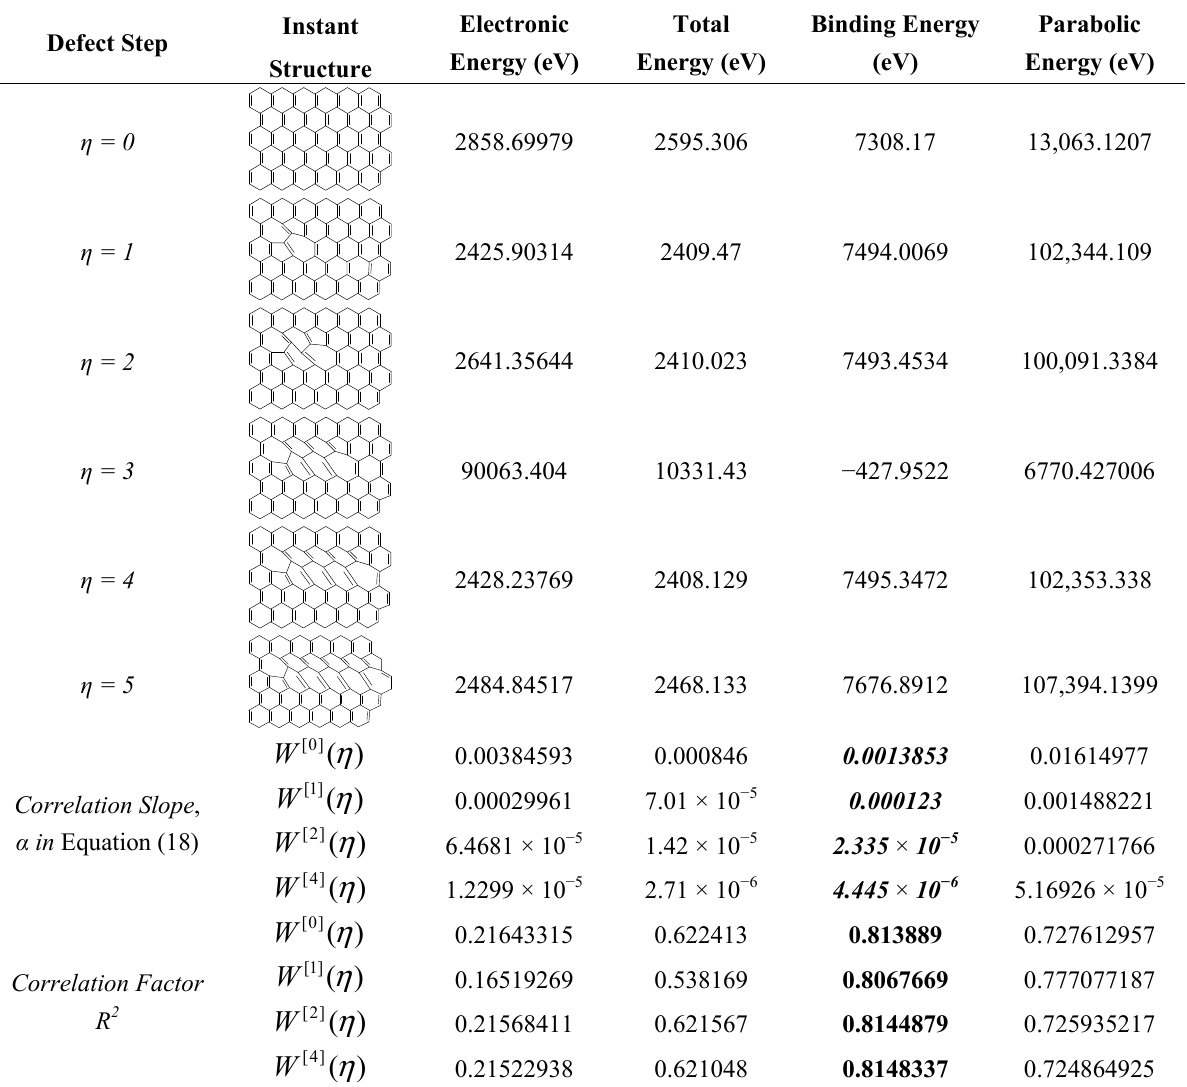
Table 2. Synopsis of the topo-reactive parameters for the defects instances (starting from pristine net at the step η = 0) from the SW propagations in Graphene sheet as described in Figure 2, namely: electronic, total, binding and parabolic energy–the last one computed upon Equations (25) and/or (26) with the total number of pi-electrons N π = 82 for the steps η = 0 ÷ 4 and N π = 84 for the last instant case η = 5, within the semi-empirical AM1 framework [39], respectively; the bottom of the table reports the free intercept correlation slopes and the associate correlation factors for each set of structural energies respecting the topological defective Wiener potential values of Table 1, providing the actual hierarchy (bolded values) and the calibration recipe (bolded italic) then used to generate the working potential polynomials of Equations